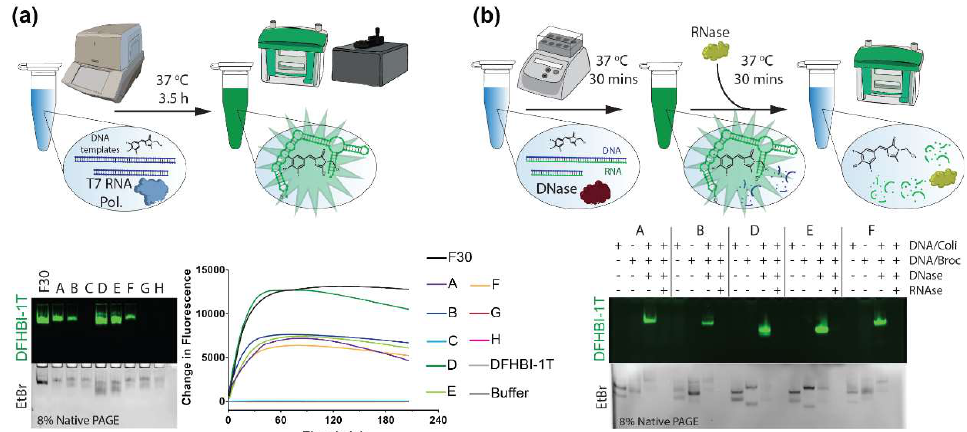
Figure 2. Enzyme-assisted activation and deactivation of fluorescent responses. ( a ) Co-transcriptional assembly of fluorets in the presence of DFHBI-1T. ( b ) DNase-assisted production of active fluorets from RNA/DNA duplexes, and their further deactivation with RNases.